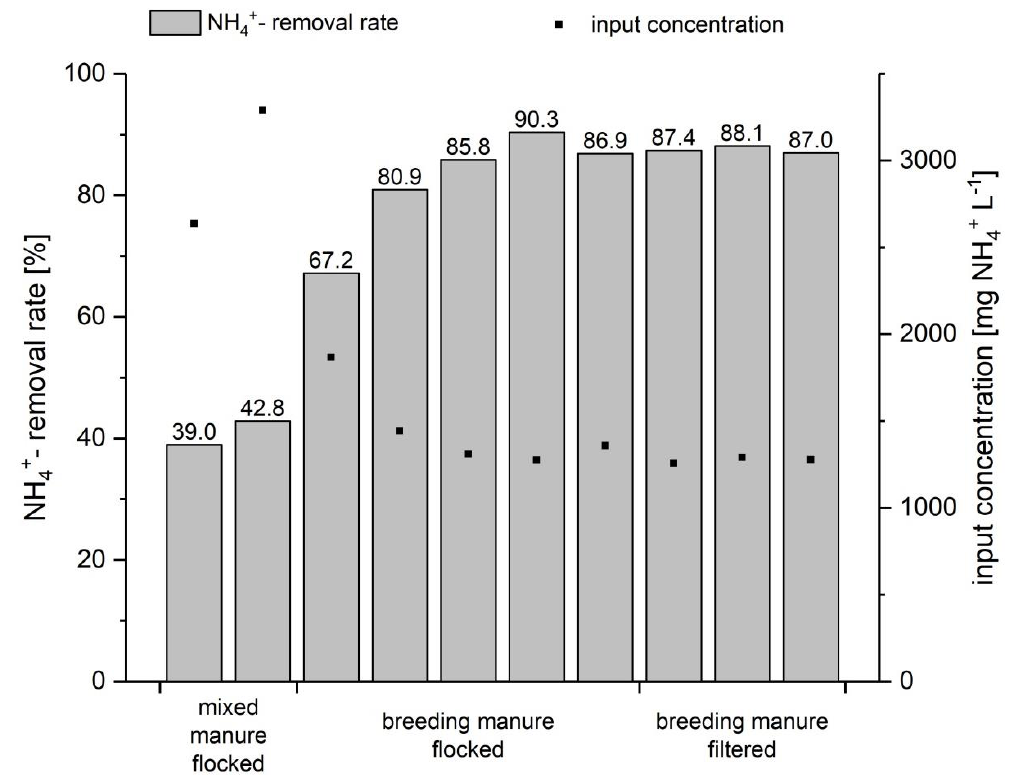
Figure 3. Ammonium removal rates (%) and input concentrations (mg NH 4+ L −1 ) of different manure qualities after preprocessing (single column operation).